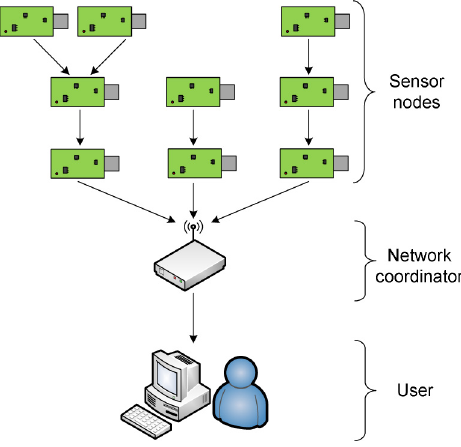
Figure 5. WSN communication scheme for wildfire monitor- ing